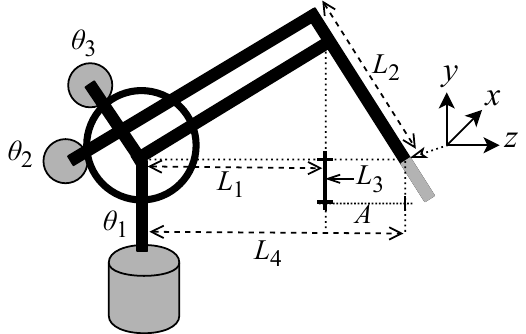
Figure 3. PHANToM Omni structure—MD and